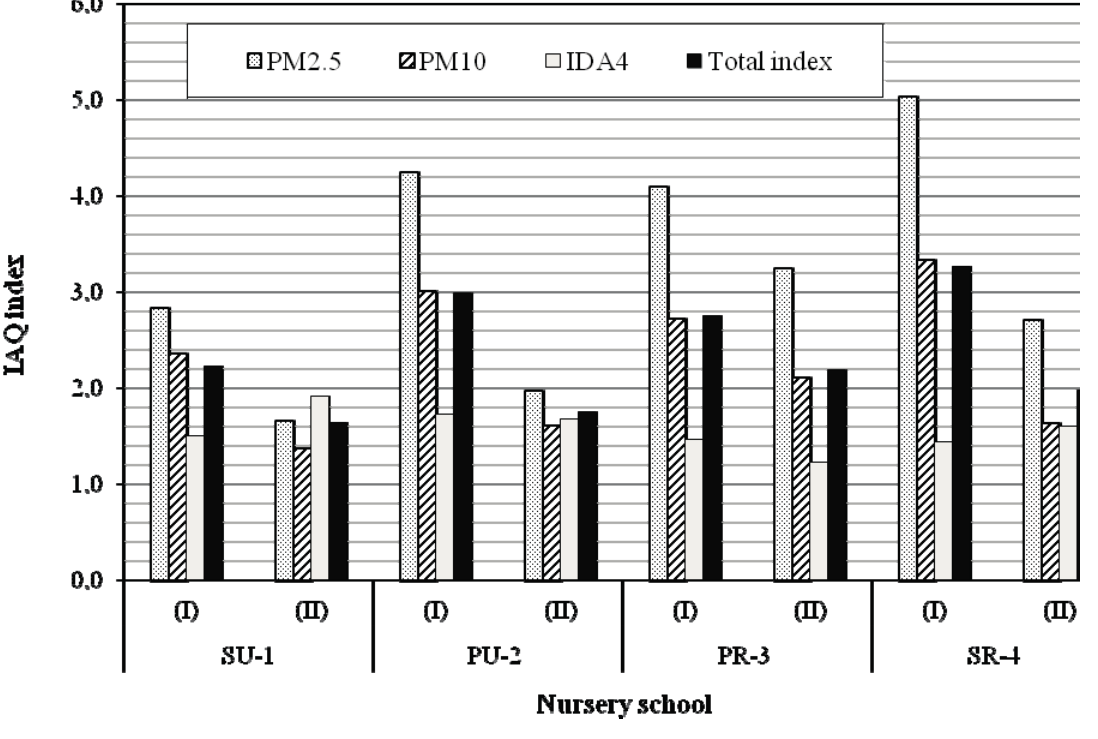
Figure 3. Integrated Indicator -IAQ